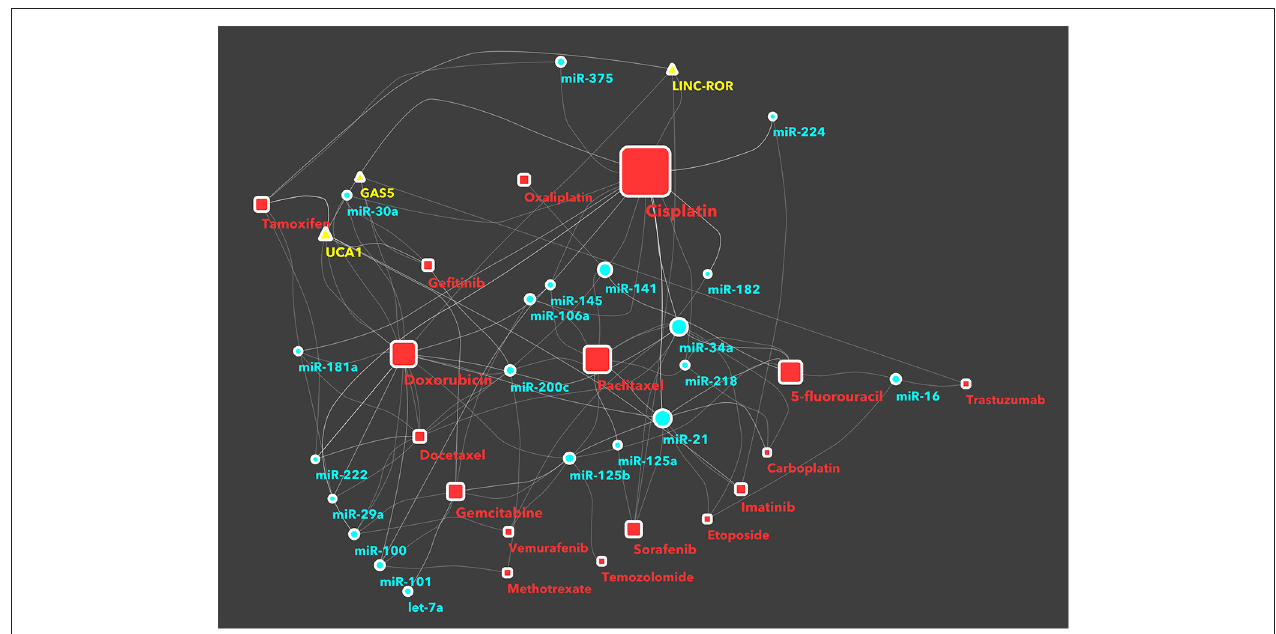
FIGURE 1 | The network of non-coding RNAs and anti-cancer drugs. Each link between a drug and an ncRNA indicates a study in literature, investigating on the specific chemoresistance involvement of that ncRNA in cancer. The nodes (a ncRNA or a drug) shown in this figure have a degree > 3, a central position in the network (expressed as betweenness centrality in the network description) > 0.003, or a closer position relative to the companion drug (expressed as closeness centrality > 0.26). The full network, with all nodes, is reported in supplemental information as Supplementary Image 1 . Drugs are represented as red squares, miRNAs as light blue circles and lncRNAs as yellow triangles. The size of a node is proportional to its betweeenness centrality, while the size of a node name is proportional to its